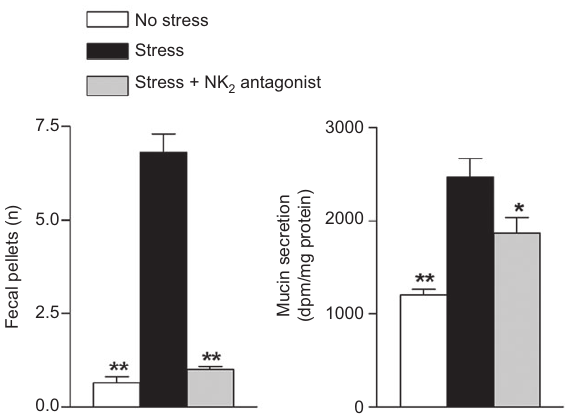
Figure 6 Effect of the TK NK2r antagonist MEN 10627 on stress- induced defecation and mucin release in rats.